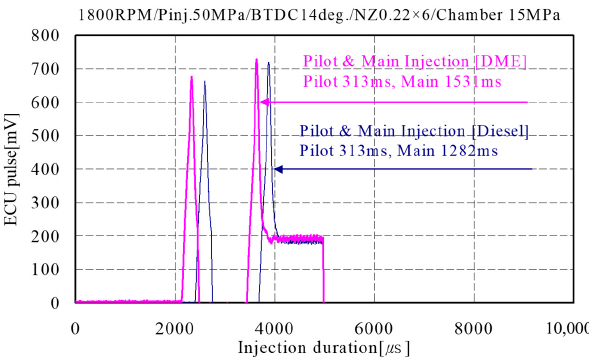
Figure 4. Two-way valve control signals for fuel injection with pilot injection for DME and diesel.